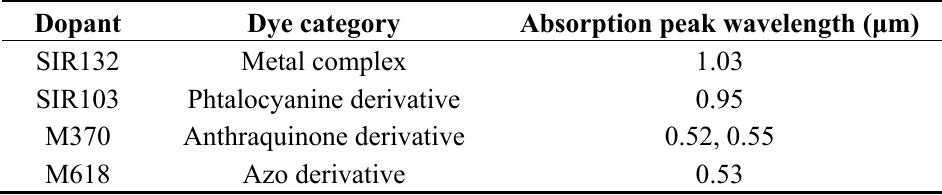
Figure 1. ( a ) Cross-sectional (polymer/liquid crystal) composite film (PLCF) with no voltage; ( b ) Cross-sectional PLCF with a voltage exceeding a threshold. Small bars are liquid crystal molecules. Table 1. Summary of the dichroic dyes.